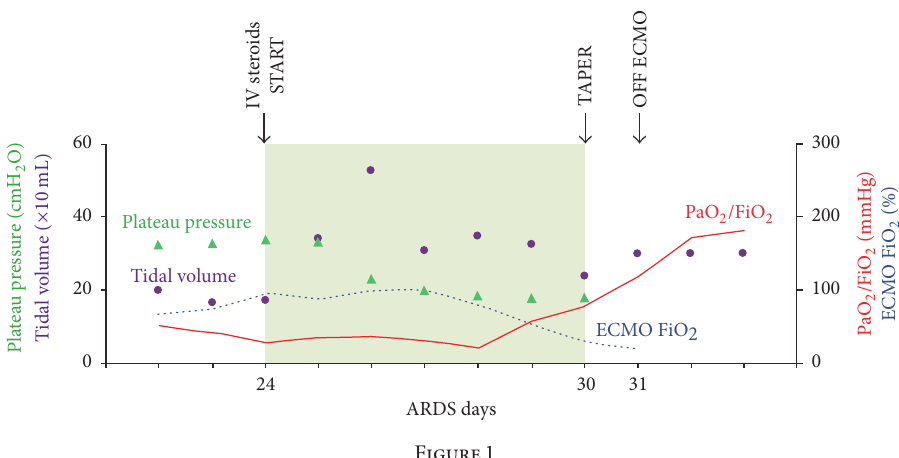
after due to carboxyhemoglobinemia and lactic acidosis.